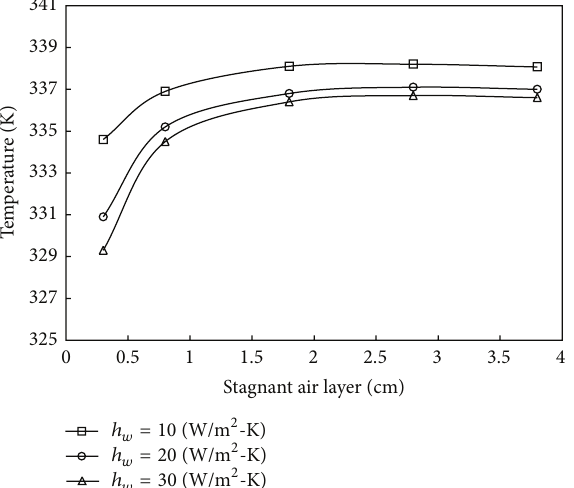
Figure 16: The outlet temperature for various widths of air layer and heat transfer coefficient of wind by CFD simulation.